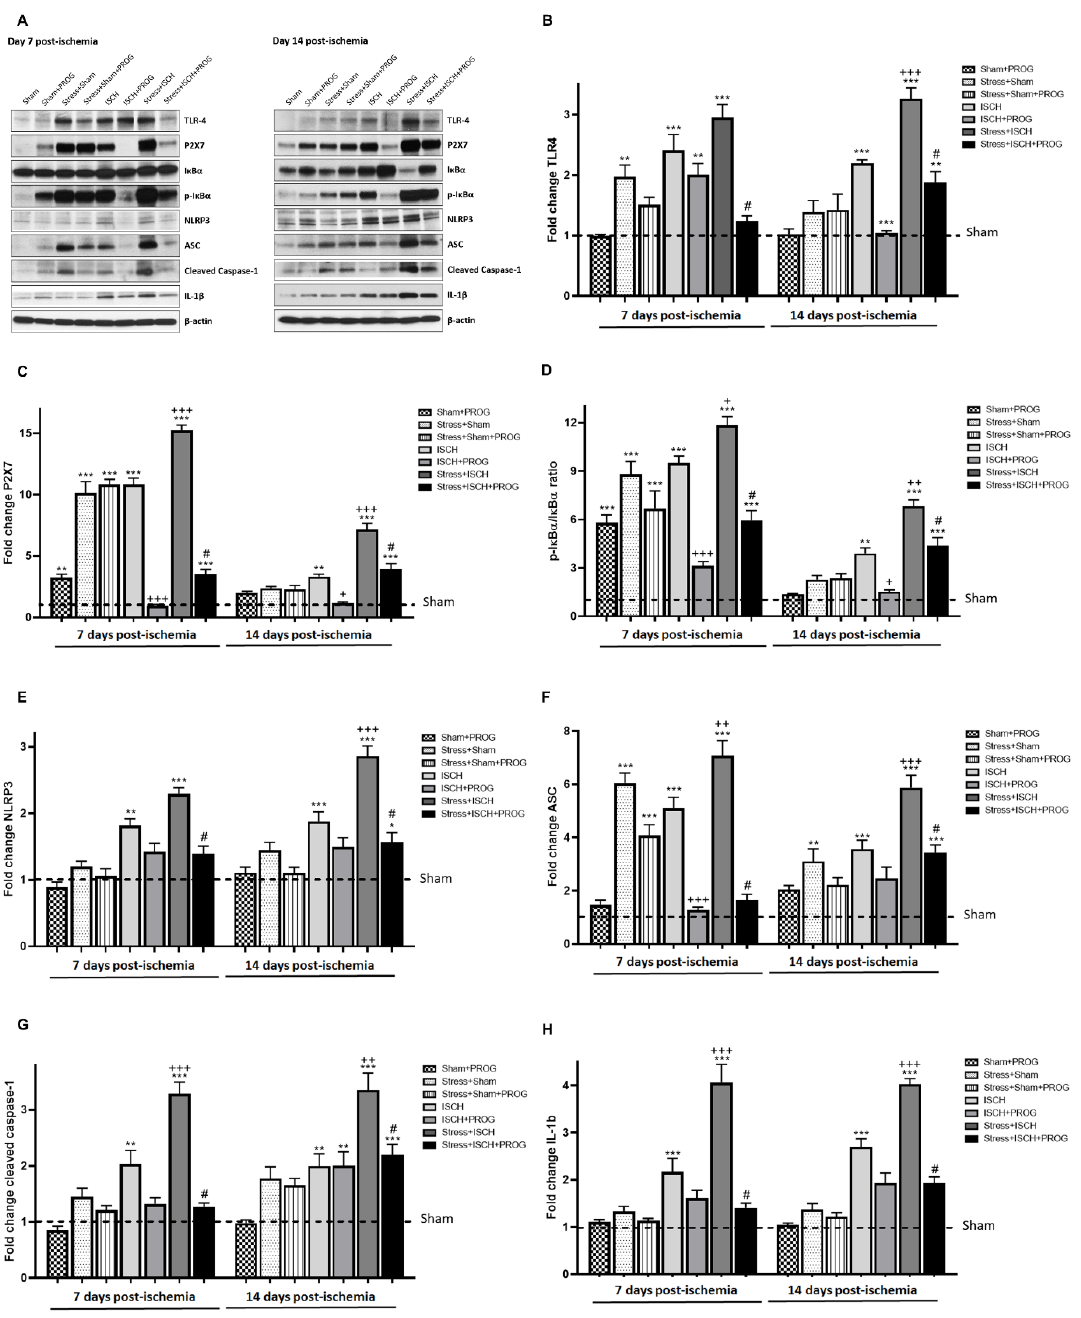
Figure 3. Effects of stress and progesterone on the NLRP3 inflammasome signaling pathway activated by global ischemia. Representative blots ( A ) and densitometry data for TLR4 ( B , ANOVA F(15, 80) = 21.22, p < 0.0001 ), P2X7 ( C , ANOVA F(15, 80) = 140.7, p < 0.0001 ), IκBα ( D , ANOVA F(15, 80) = 50.26, p < 0.0001 ), NLRP3 ( E , ANOVA F(15, 80) = 24.47, p < 0.0001 ), ASC ( F , ANOVA F(15, 80) = 33.84, p < 0.0001 ), cleaved caspase-1 ( G , ANOVA F(15, 80) = 20.56, p < 0.0001 ), IL- 1β ( H , ANOVA F(15, 80) = 38.20, p < 0.0001 ) in the hippocampus obtained from ischemic animals at 7 and 14 days after global ischemia, or from sham animals. Data are expressed as mean ± SEM. N = 6/group. * p < 0.01, ** p < 0.001, *** p < 0.001 vs. Sham; + p < 0.05, ++ p < 0.01, +++ p < 0.001 vs. ISCH; # p < 0.001 vs. STRESS+ISCH.